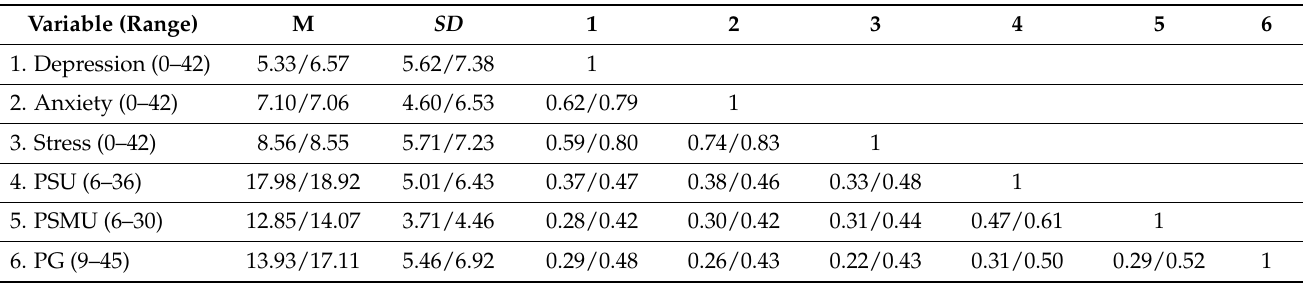
Table 2. Descriptive and correlation values between the